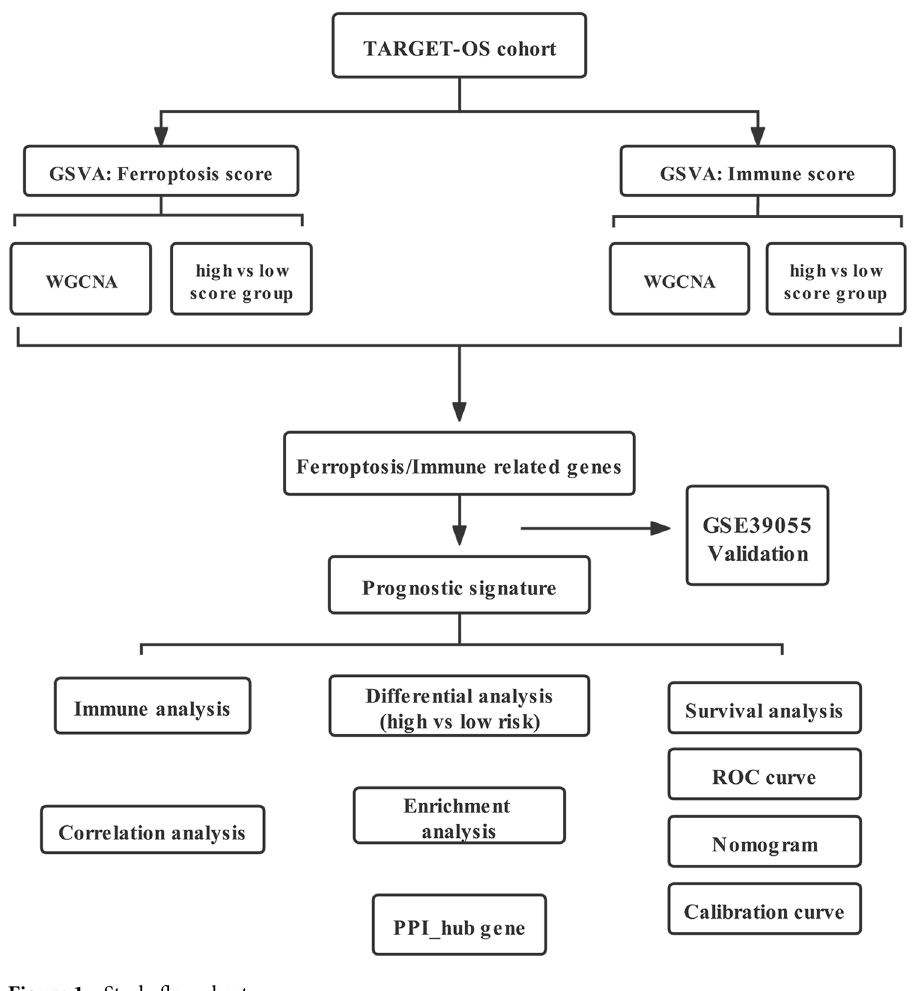
Figure 1. Study flow